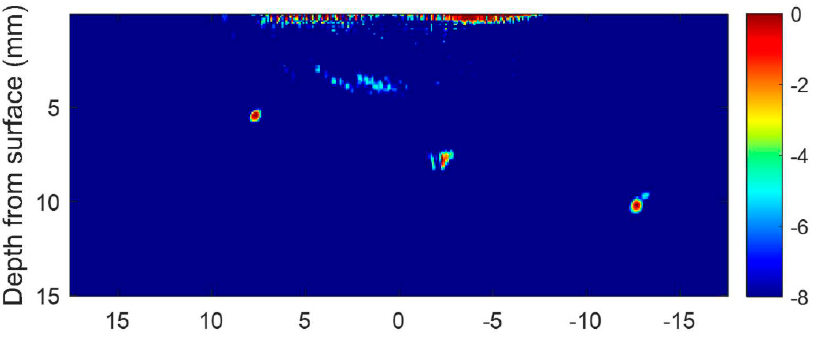
Figure 4. Intentionally introduced defects (D1, D2 and D3 in Figure 3) are detected by means of TFM image of the component using ultrasonic longitudinal waves [25].